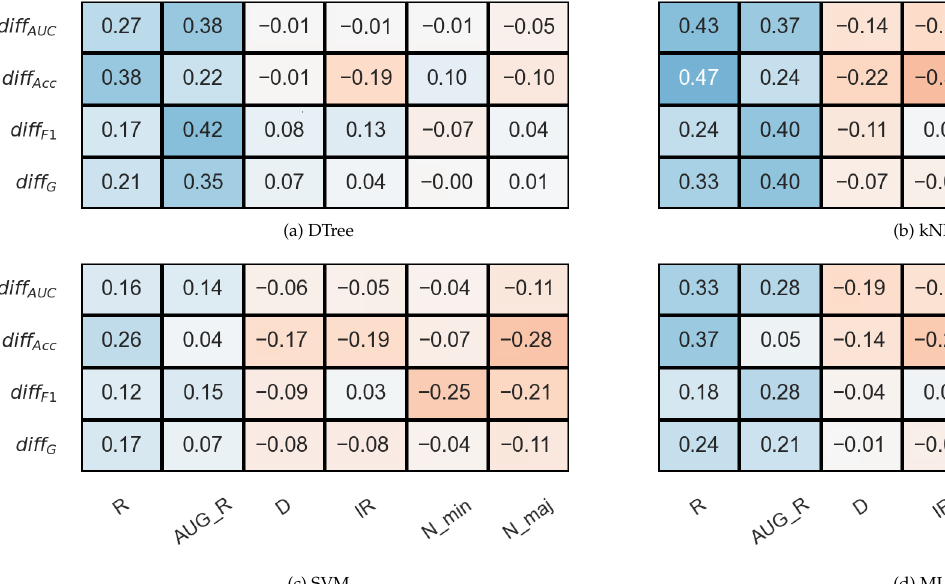
Figure 4. Result of the Spearman’s rank correlation test between some features of the KEEL data set and the difference of the DOB and SCV results of the classification combined with oversampling obtained on the data sets.